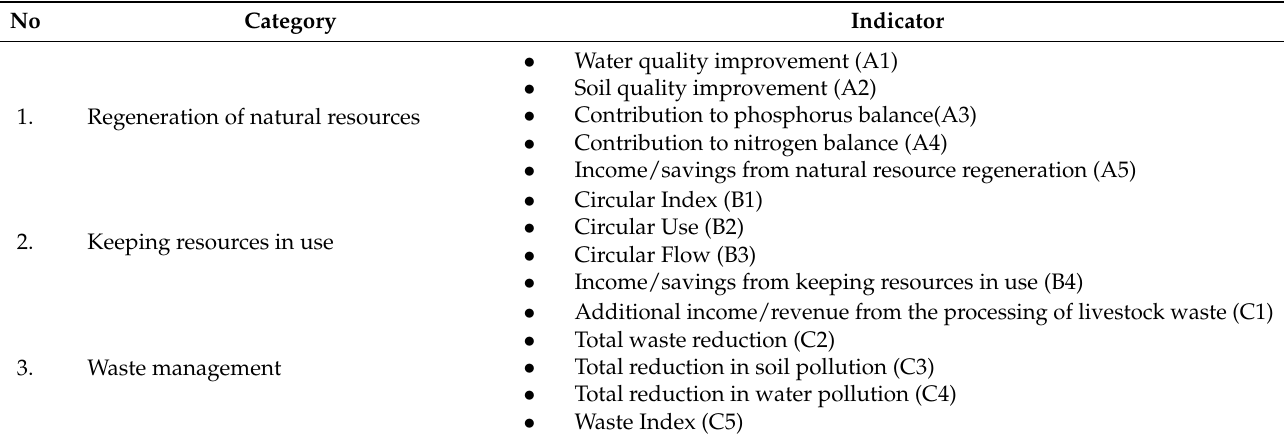
Table 3. Categories and Indicators of